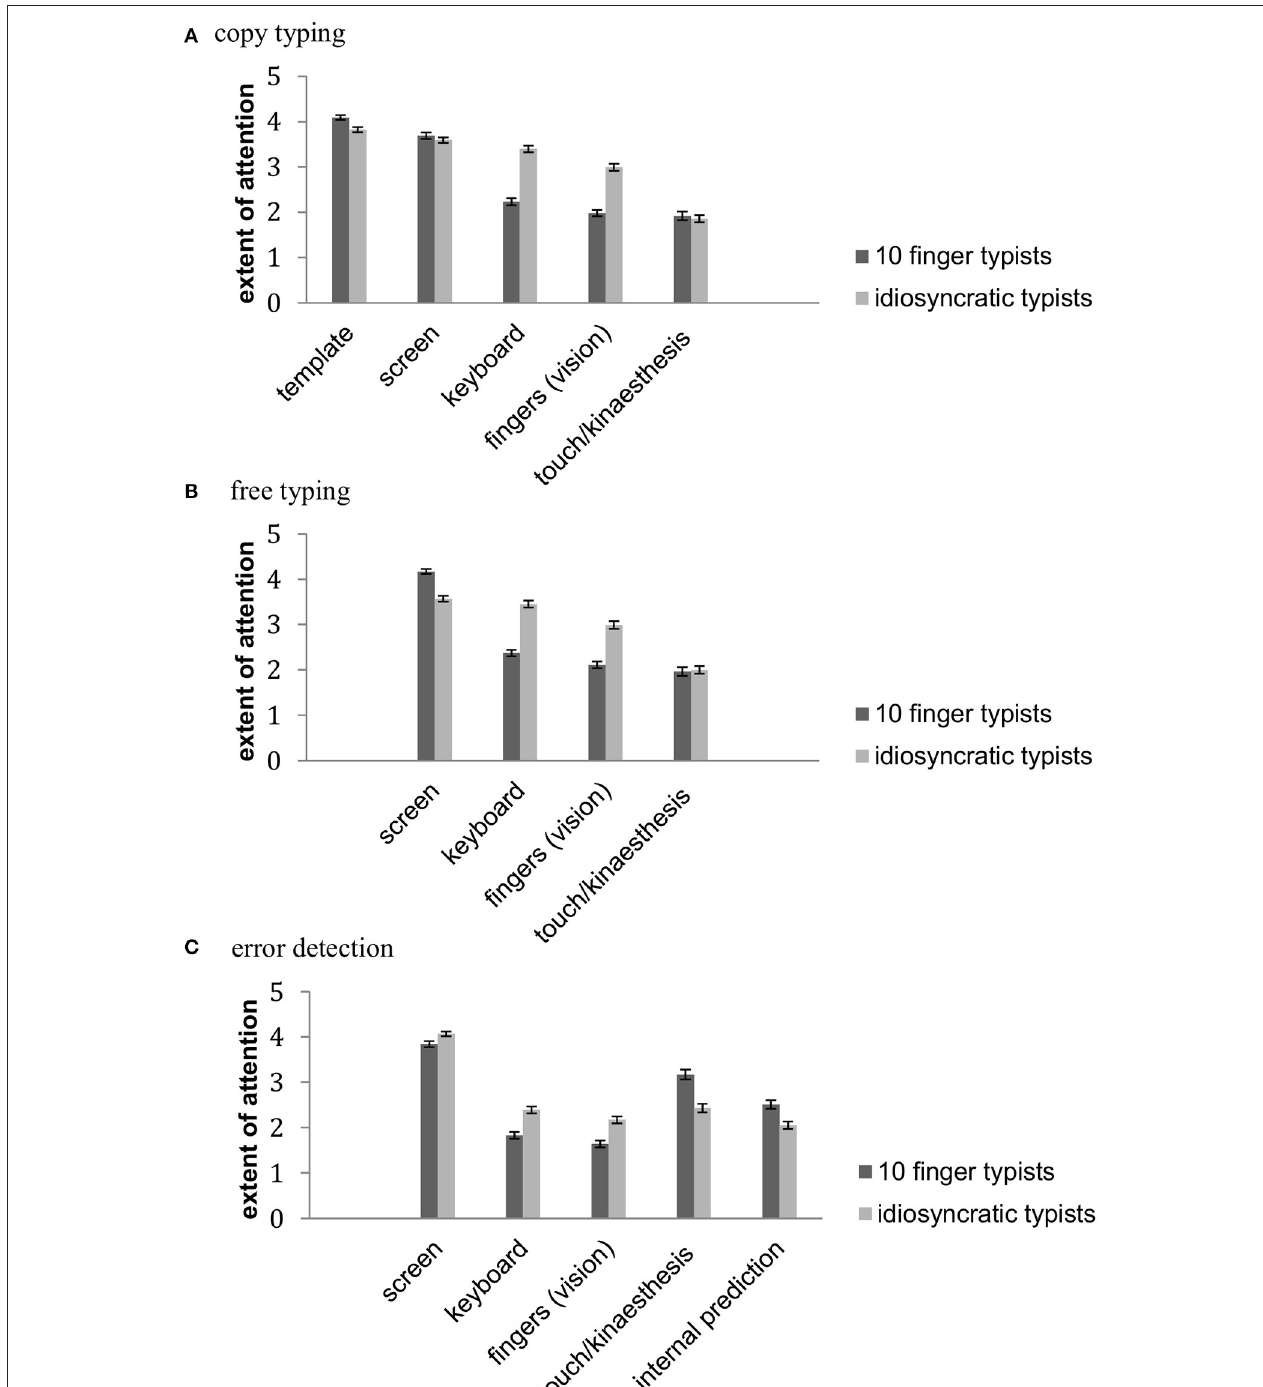
FIGURE 1 | Means and standard errors of the reported extent of attention to different sources of information in (A) copy typing, (B) free typing, and (C) the use of the sources of information for error detection in 10 finger typists and idiosyncratic typists.